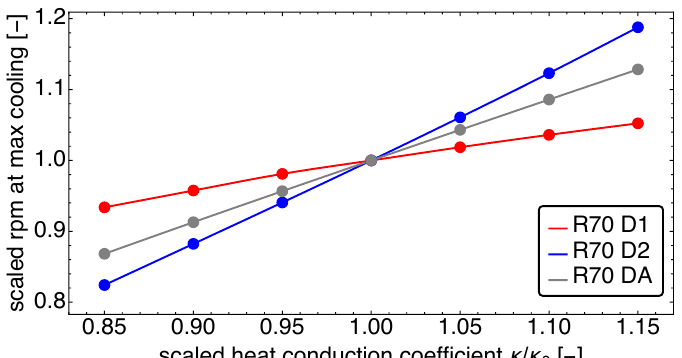
Figure 13. The rescaled engine speed at maximum cooling power is shown as function of the rescaled heat transport coefficient for the three engine designs D1, D2, and DA, and r = 0.7 regeneration extent. The rescaling is with respect to the properties of the maximum cooling power operating point for the base